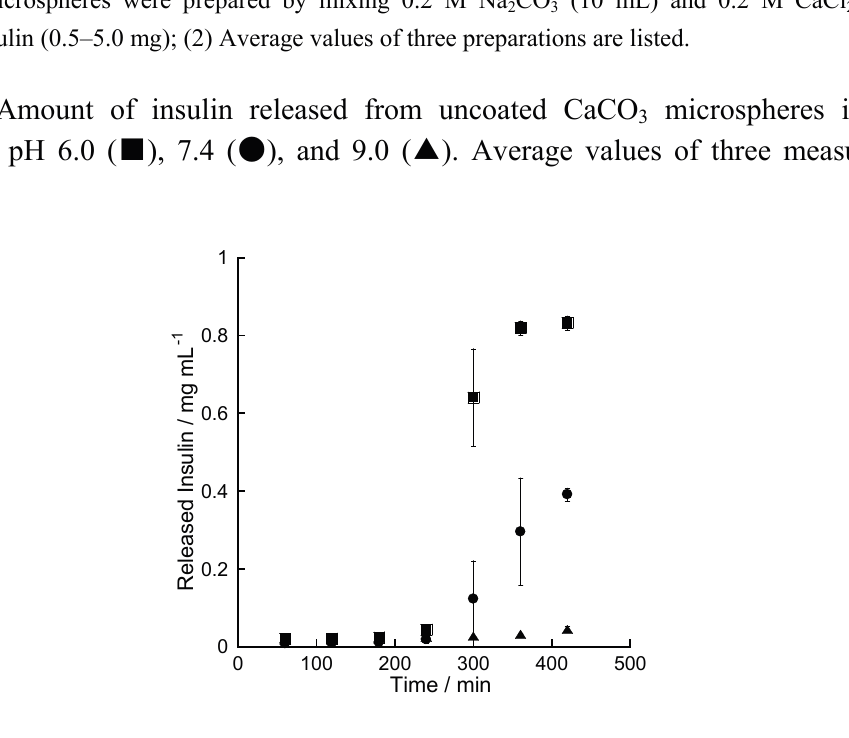
microspheres in buffer 3